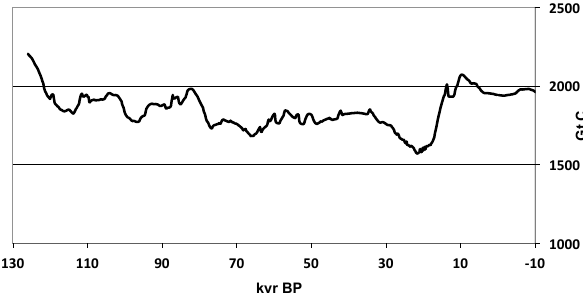
Fig. 3. Dynamics of the total terrestrial carbon storage (soil plus biomass in GtC) in the PCBL